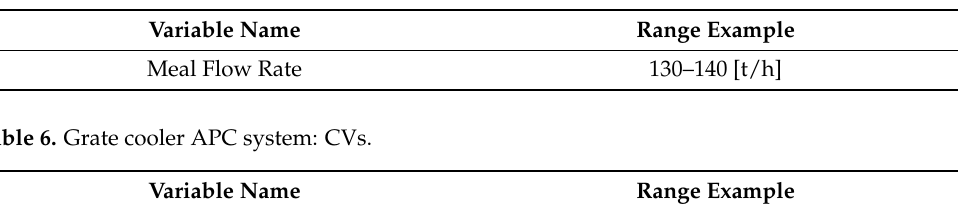
Table 5. Grate cooler APC system: DVs.